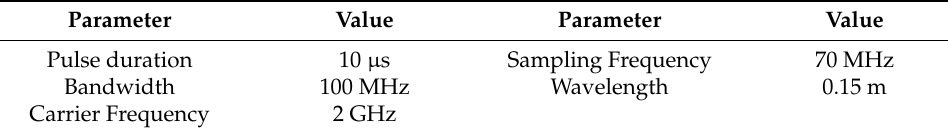
Table 1. Radar signal parameters. Table 2. Radar signal parameters.